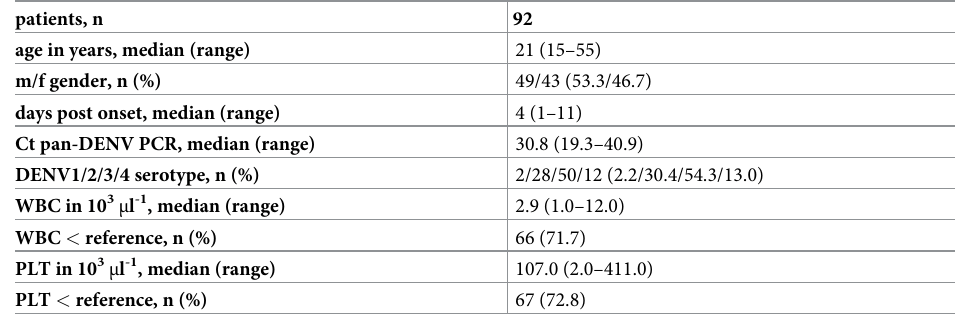
Table 1. Demographic and clinical parameters of DF patients (Lao PDR